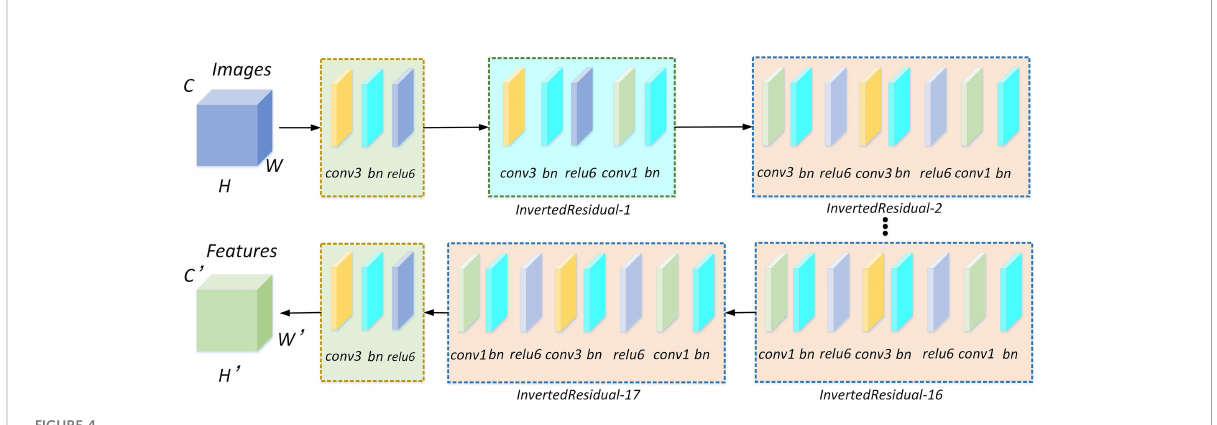
FIGURE 4 MobileNetV2 network for feature extraction. There are 17 inverted residual modules included in the network. Each inverted residual module consists of a depthwise separable convolution, and the depthwise separable convolution is composed of 1×1 and 3×3 standard convolutions, batch normalization, and relu6 activation